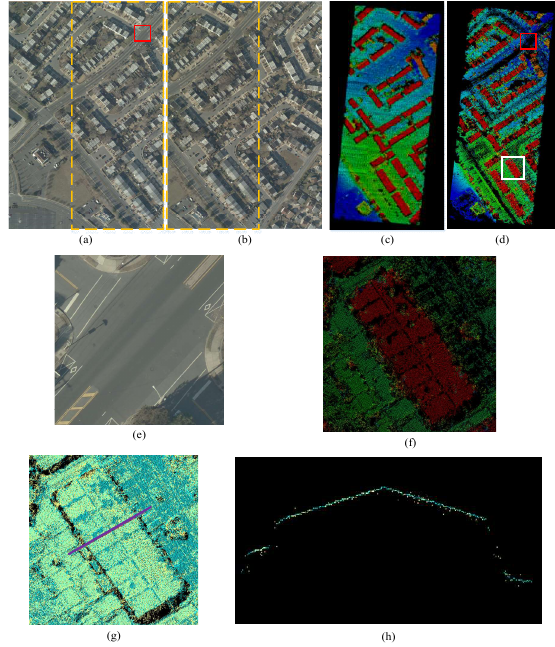
Figure 5. Matching result of S1 and comparison with SGM, where (a) and (b) are the base and matching images of the stereo pair, respectively, and the areas within the dashed boxes represent the overlapping of the image pair; (c) is the result of SGM (coloring by elevation of the point, the higher the redder, otherwise, the lower the more blue); (d) is the result of our method (the coloring is the same as (c)); (e) is the enlarged view of the area in the red rectangle of (a) and is also the base image of the unmatched area in the red rectangle of (d); (f) is the enlarged view of the area in the white rectangle of (d); (g) is the enlarged view of the same area of (f), but the SGM result (the blue point) and our result (yellow point) are put together; (h) is a profile of the purple line in